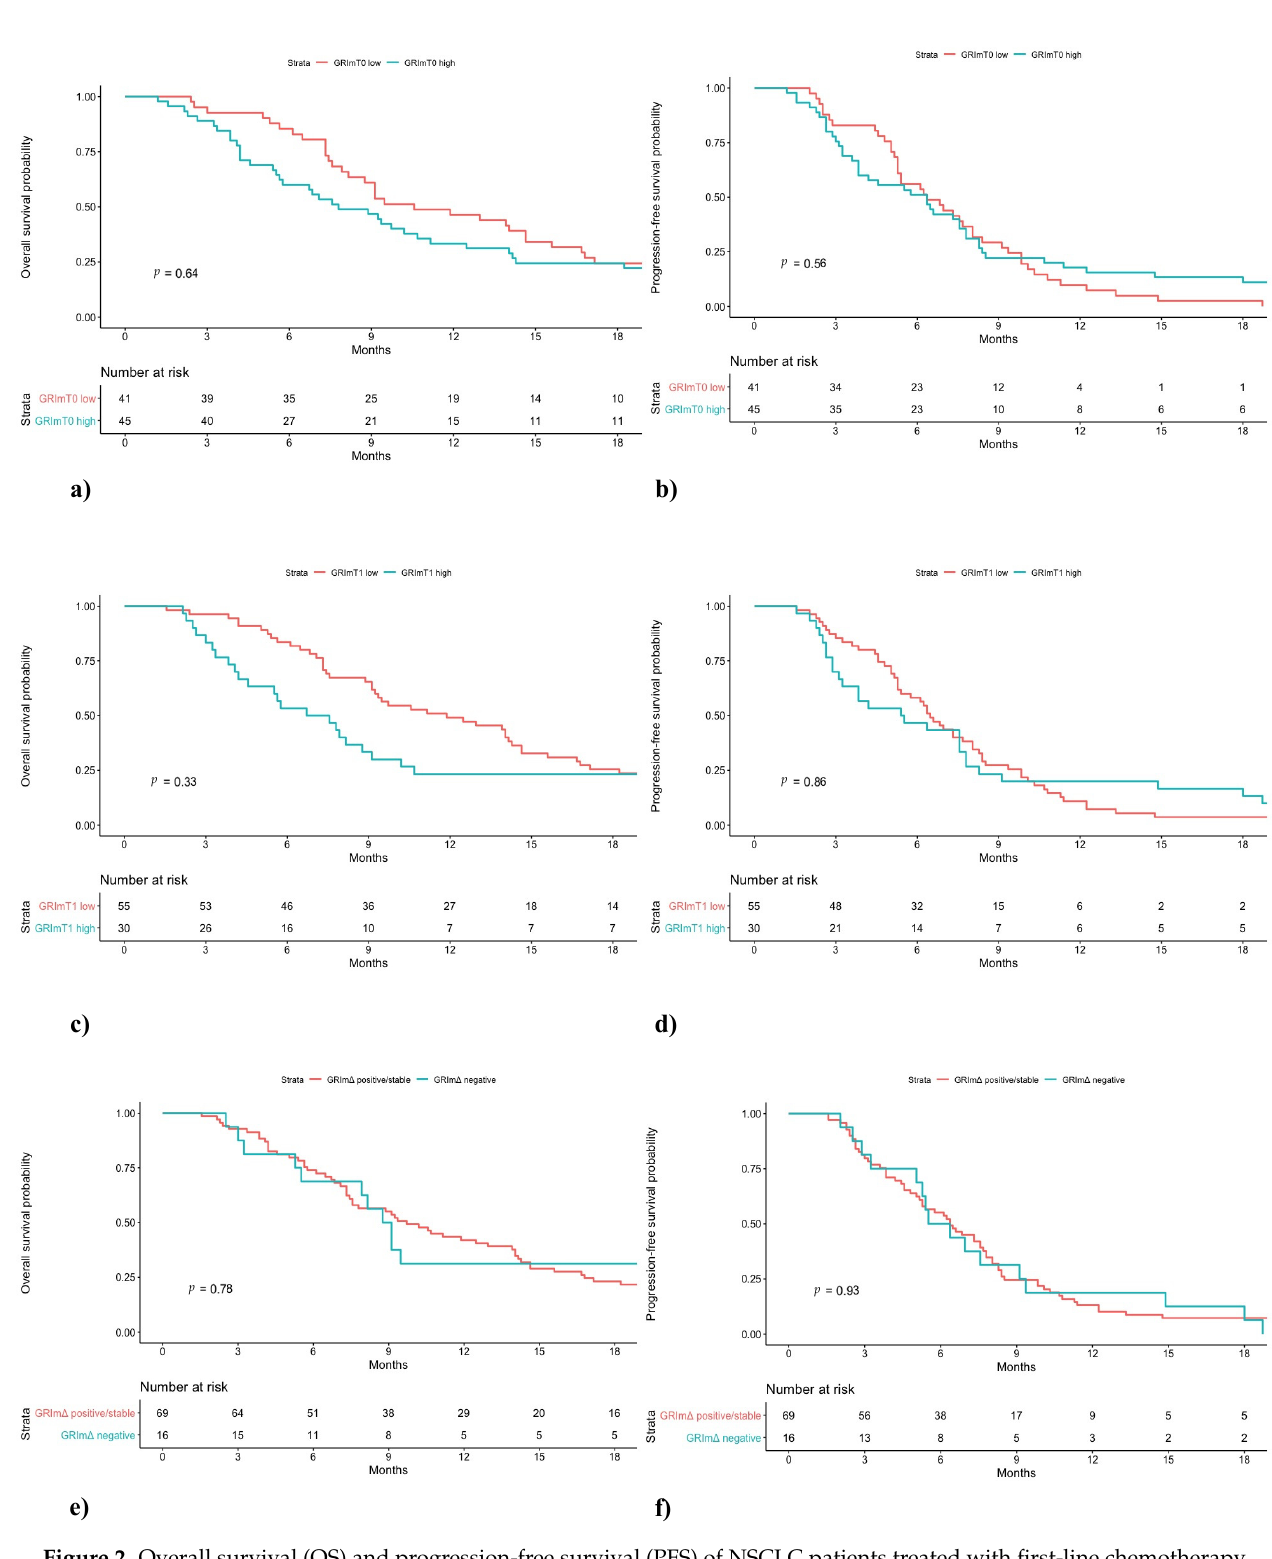
Figure 2. Overall survival (OS) and progression-free survival (PFS) of NSCLC patients treated with first-line chemotherapy stratified by GRImT0 ( a , b ), GRImT1 ( c , d ) and GRIm Δ ( e , f ) values.